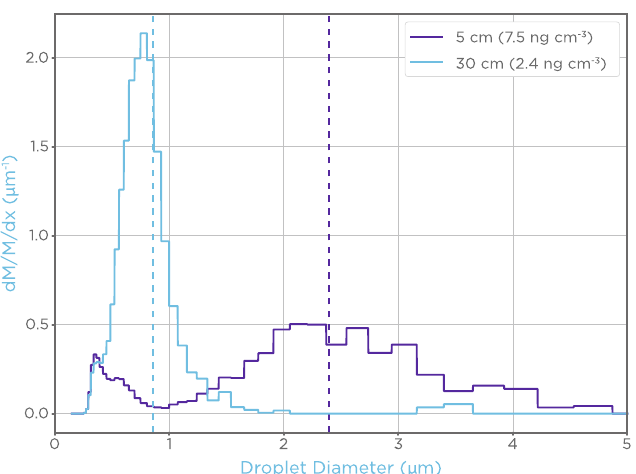
Figure 3. Particle mass distributions were measured based on two dilution path lengths. The particle probability density by mass (dM/M/dx) at a given particle diameter was measured by an optical particle counter placed 5 or 30 cm from the dilution region. The mass mean particle size (dashed line) was 2.4 µm and 0.9 µm when measured at 5 and 30 cm from the dilution region, respectively. The total collection efficiency by mass of the aerosol by the filter was > 99.8% (see Supplementary Fig. 4).